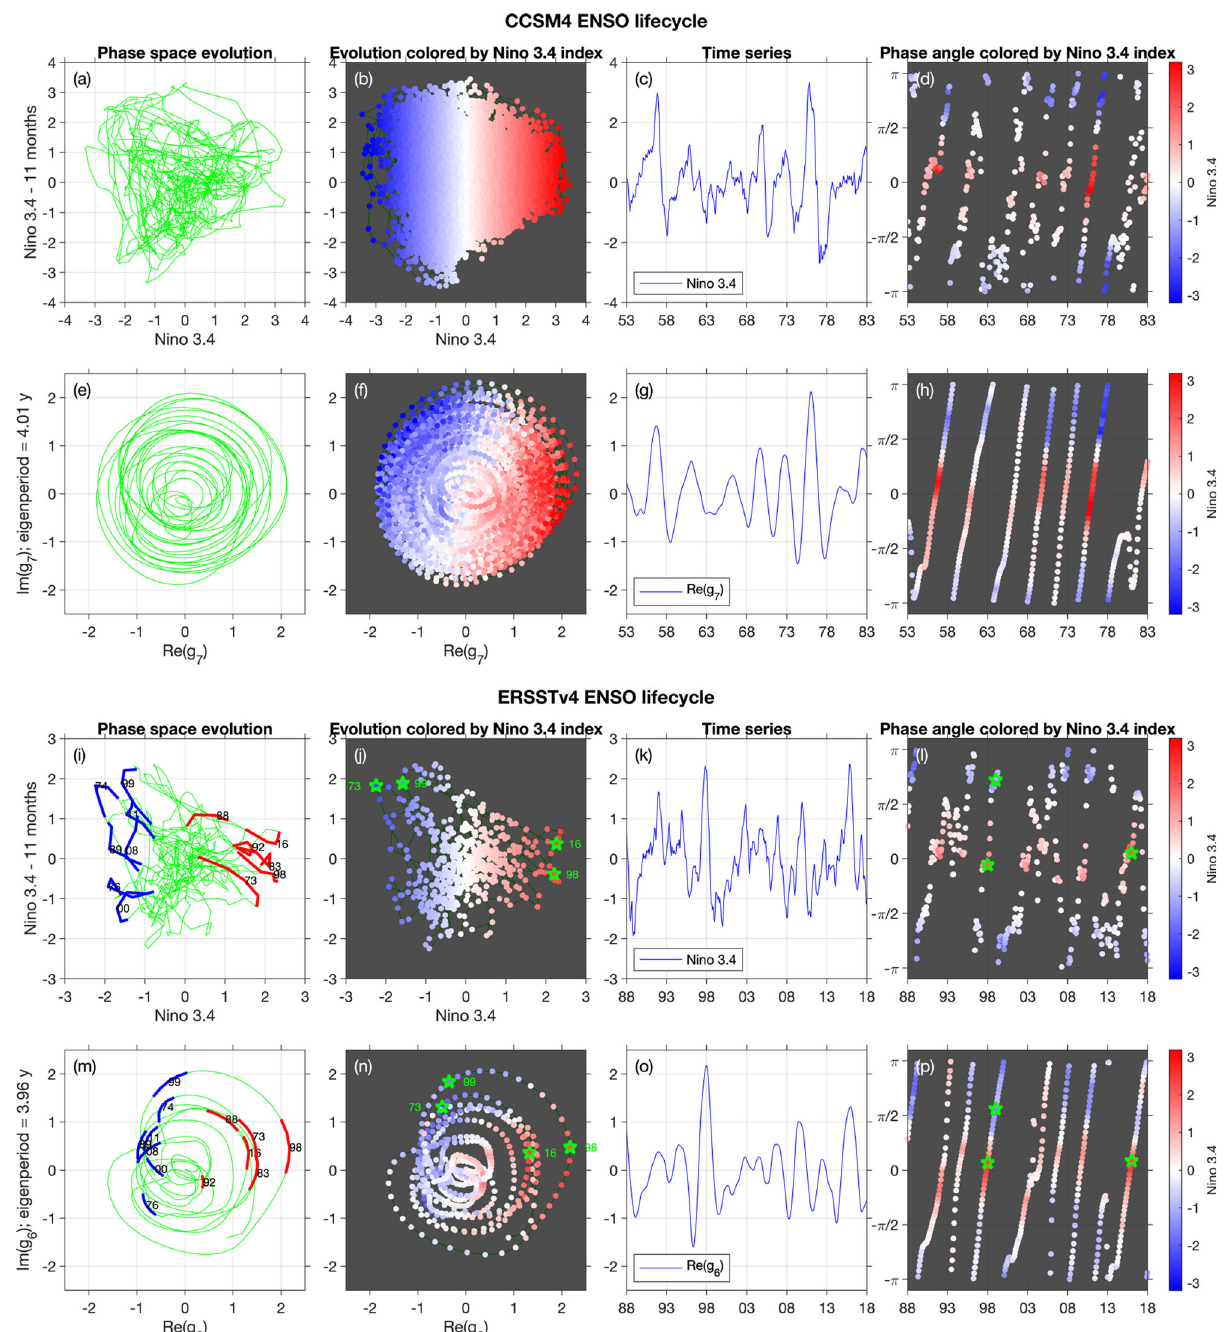
Fig. 5 ENSO lifecycle for CCSM4 (a – h) and ERSSTv4 (i – p), reconstructed using lagged Niño 3.4 indices f nino and the complex eigenfunction g j of the generator. a , e , i , m The evolution of the ENSO state in the 2D phase spaces determined from the Niño- ( a , i ) and generator-based ( e , m ) indices. For clarity of visualization, in a we show the evolution over a 100-year portion of the 1300-year dataset. Signi fi cant historical El Niño and La Niña events are marked in red and blue lines in m for reference. b , j (resp. ( f , n )) show scatterplots of the original (resp. recti fi ed) Niño- and generator-based lifecycle colored by the Niño 3.4 index. These plots are analogous to the original and recti fi ed oscillator plots in Fig. 4 ( d , e ), respectively. c , g , k , o The Niño 3.4 time series ( c , k ) and the real part of g j ( g , o ), plotted over a 30-year portion of the available data. These time series are analogous to those in Fig. 4 ( c , f ) respectively. d , h , l , p The phase angles determined from f nino ( d , l ) and g j ( h , p ). Note that the slope in h , p is approximately constant, consistent with the automatic recti fi cation process, namely that trajectories precess around the origin at a fi xed angular speed. This regular recti fi cation from our complex eigenvector is in strong contrast to the irregular angular behavior of the lagged Niño 3.4 index in d , l In interpreting the results in Fig. 6 and Supplementary Table 3, frequency. In the case of the observational data, the spectrum also it should be kept in mind that, modulo a small amount of contains a trend-like mode representing climate change, as well as numerical drift, the CCSM4 data are generated by autonomous combination modes representing the modulation of the annual dynamics associated with fi xed (pre-industrial) concentrations of cycle by the trend (see Supplementary Fig. 1).